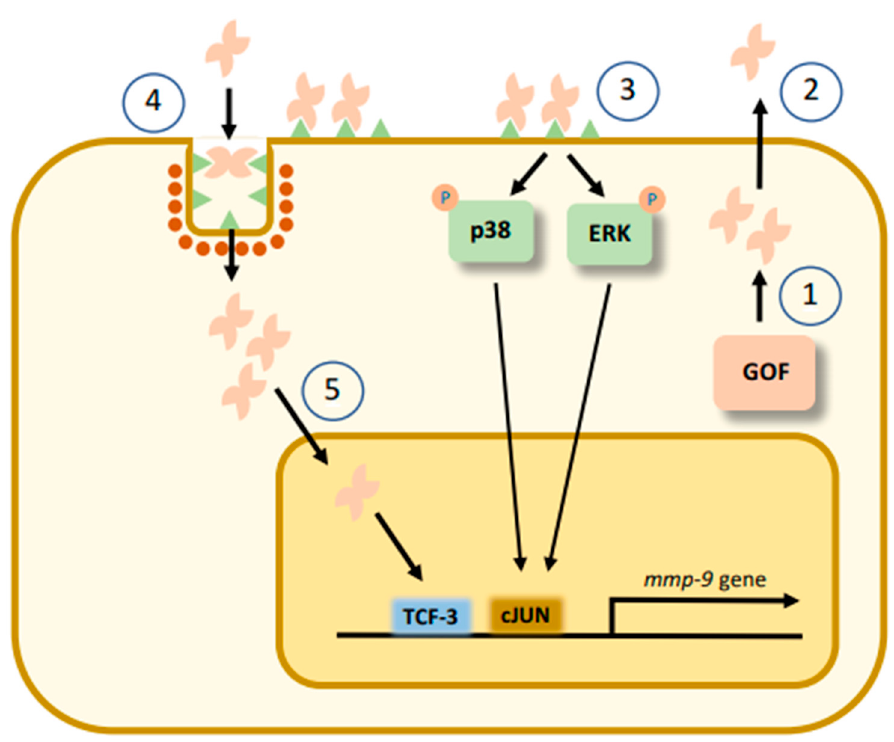
Figure 3. A working model for the control of MMP-9 gene expression in cancer cells via galectin-7. De novo expression of galectin-7 in cancer cells by the GOF pathway leads to accumulation of intracellular galectin-7 (1). Intracellular galectin-7 translocates directly to the nucleus to trigger MMP-9 gene expression (5) or be released by cancer cells in the extracellular tumor microenvironment (2). Once outside cancer cells, extracellular galectin-7 can bind and activate glycoreceptor-mediated signaling pathways that lead to MMP-9 gene expression (3). Such a mechanism can be activated in adjacent cancer cells or in the same cell following an autocrine mechanism (4).